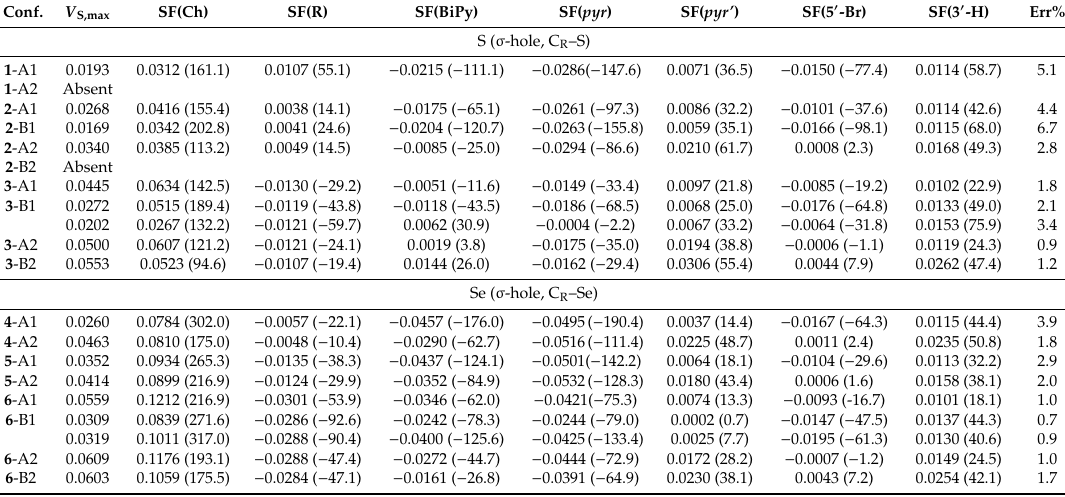
Table 5. V S,max (au) and their Source Function (SF) atomic group contributions on C R –Ch (Ch = S, Se) σ -holes (0.002 au molecular surface) calculated for the various conformers of systems 1 – 6 . In parentheses the SF percentage values are reported. The Err% value (see text) provides a measure of the SF V S,max reconstruction